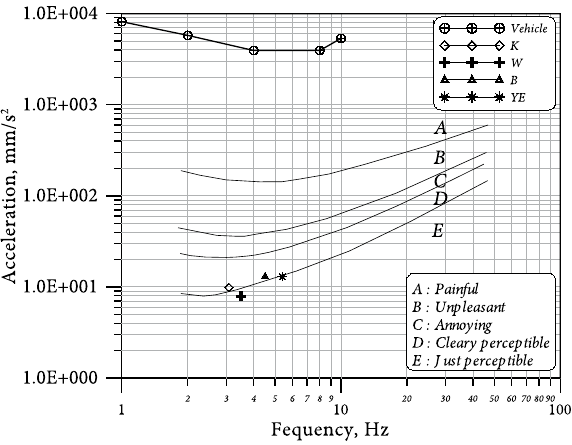
Fig. 3. Comparison between Reiher-Meister and various